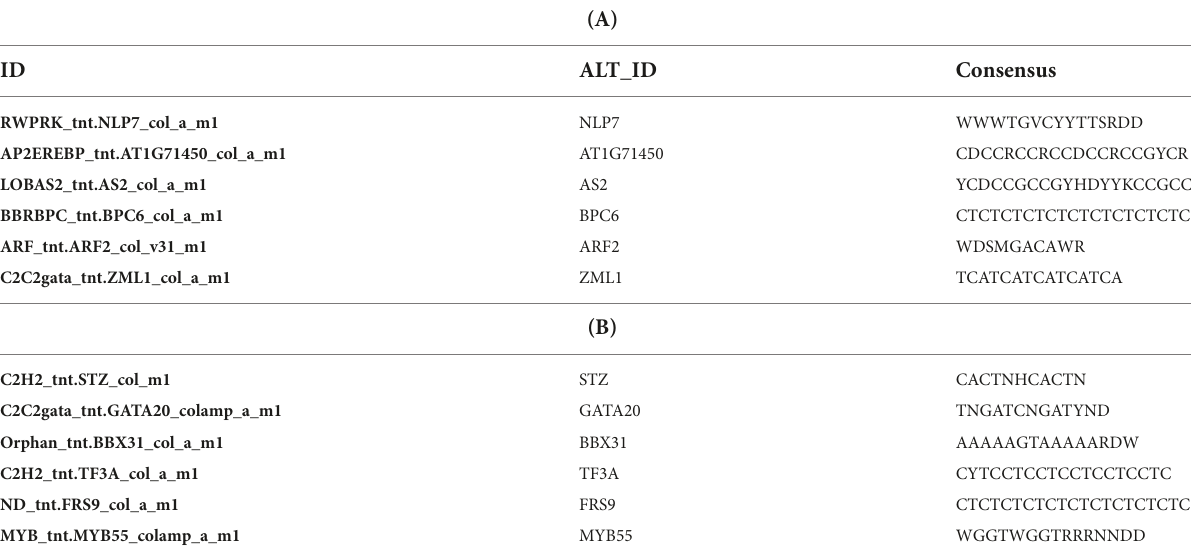
TABLE 5 (A) Putative TF binding sites in “early” NCR promoter regions predicted by the SEA tool. (B) Putative TF binding sites in “late” NCR promoter regions predicted by the SEA